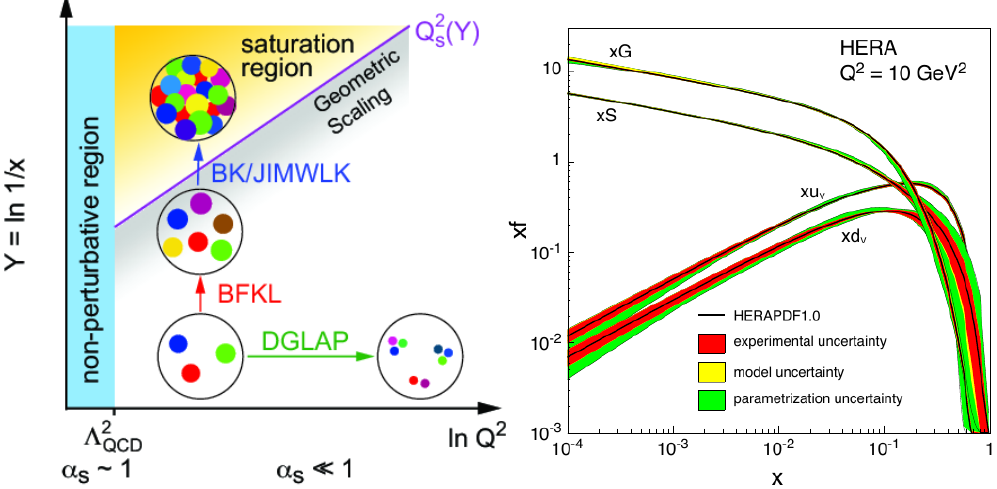
Figure 2. Left : the QCD landscape, the horizontal axis Q 2 represents the resolution of the probe while the y -axis (ln ( 1/ x ) ) is related to the parton density. Right : Parton distribution functions in the proton plotted as functions of Bjorken x ; figures from